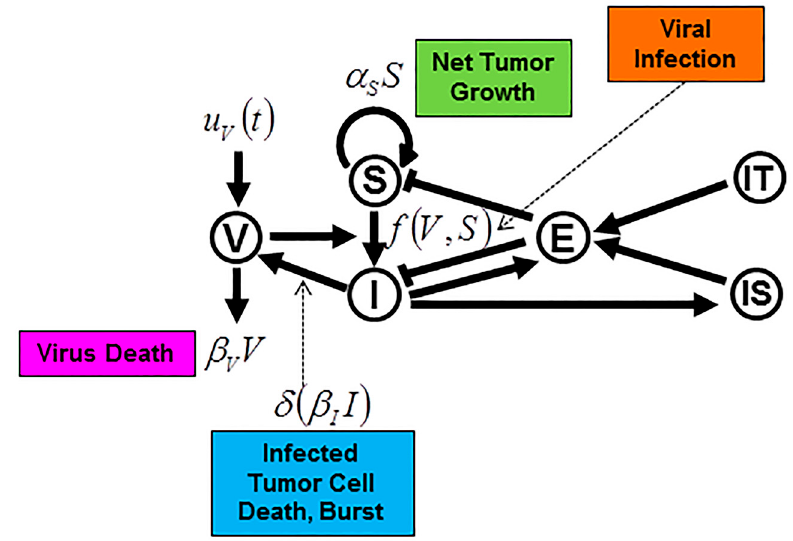
Figure 5. Explicit virus (V), and susceptible (S) and infected (I) cell model with addition of different immune system compartments (E, effector; IS, other immune system compartments such as antigen presenting cells) and immunotherapy (IT). Here, the effect of dendritic cell injection IT is modeled as an increase in effector cells. U V ( t ) describes the time-dependent introduction of the virus population. Second-order terms and interactions (death/exhaustion) left out for clarity. Note that the viral infection term f ( V , S ) = β SV in [105]. See Figure 2b for comparison.